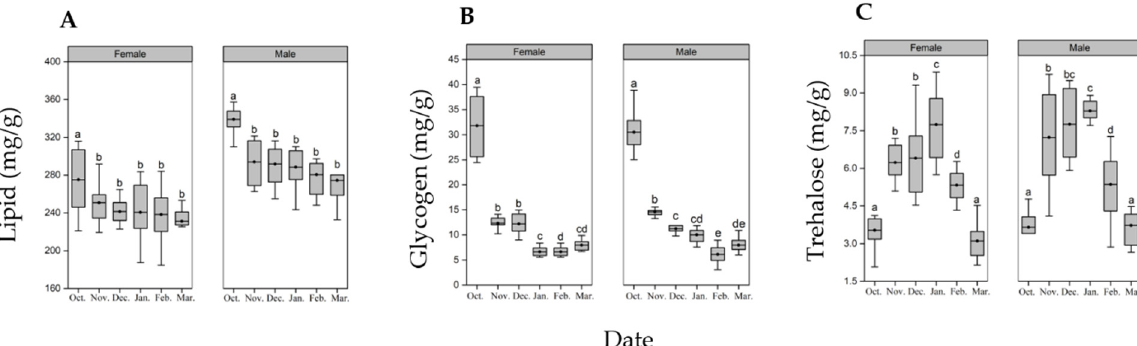
Figure 3. Seasonal patterns of biochemical composition of H. cunea diapausing pupae. ( A ): lipid, ( B ): glycogen, ( C ): trehalose. Different letters indicate significant differences from one another at p ˂ 0.05 (female: n = 11–12; male: n = 10–11). The top and bottom of each box represents the upper and lower quartile, respectively; the horizontal line represents the mean; the vertical lines extend to the minimum and maximum values within 1.5 times the inter-quartile range.